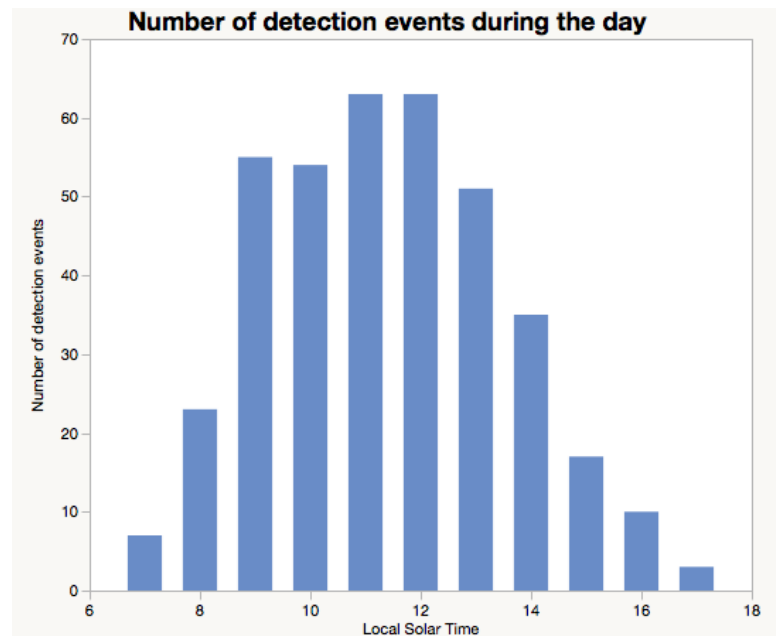
Figure 11. Activity of bees during the day. These data are from honey bees from 352 bees over the period of 24